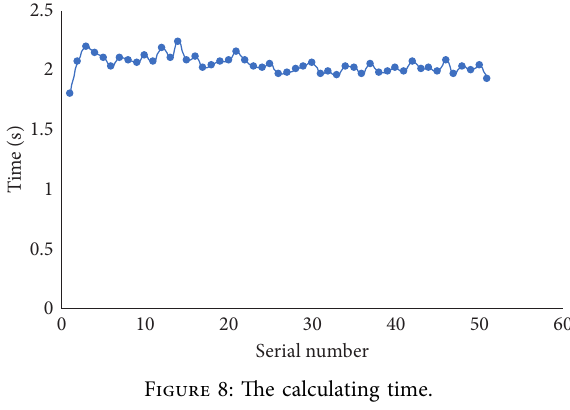
Figure 8: The calculating time.